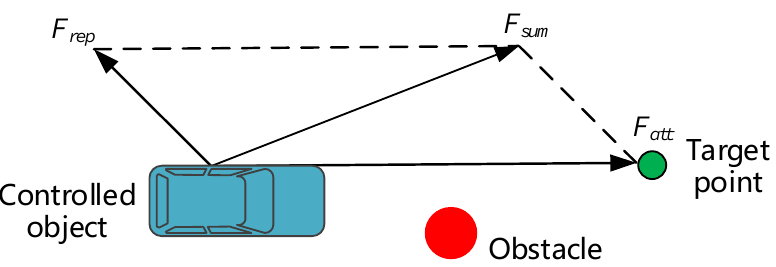
Figure 2. Model of the traditional APF algorithm.